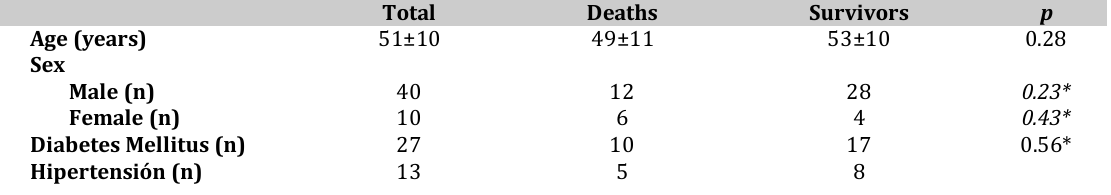
Table 1. Demographic characteristics patients with Covid-19 disease